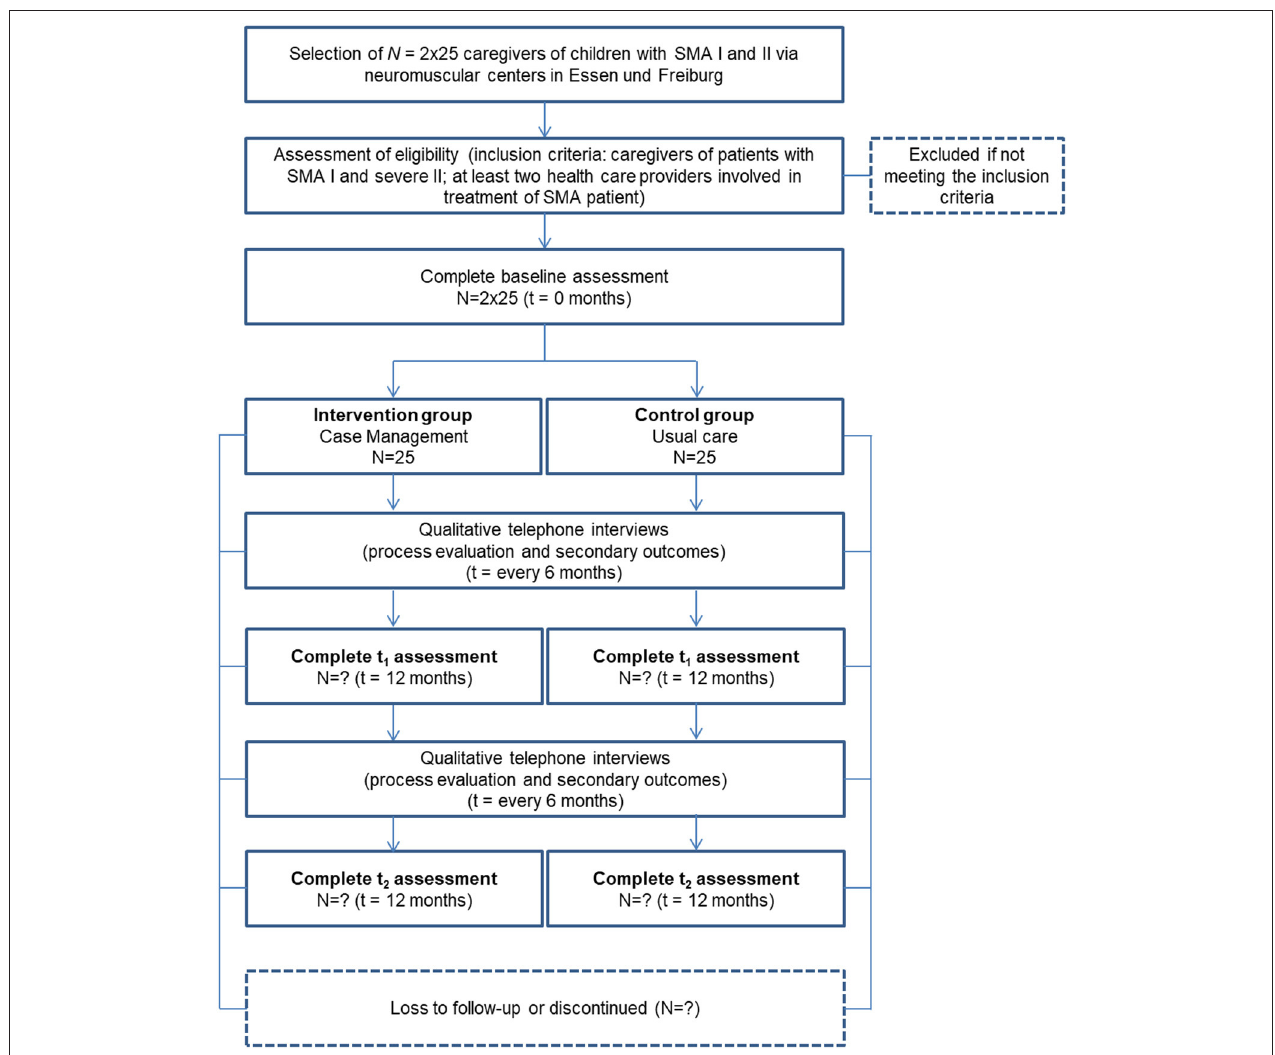
FIGURE 2 | Participant timeline of caregivers in phase